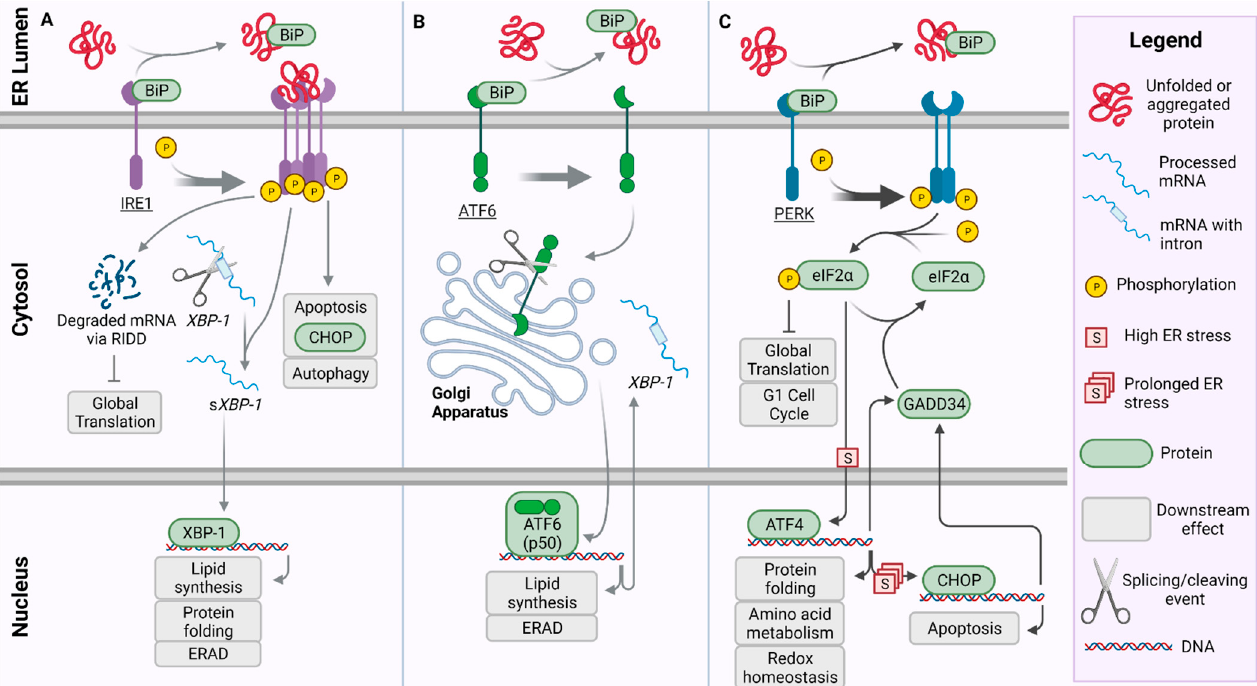
Figure 1. Pathways of the Unfolded Protein Response (UPR): In the presence of unfolded or aggregated protein, BiP dissociates from the three ER stress sensors: activating inositol requiring enzyme 1 (IRE1) ( A ), transcription factor 6 (ATF6) ( B ), and protein kinase RNA (PKR) like ER kinase (PERK) ( C ). The legend defines graphics for conserved structures between pathways of the UPR. ( A ) IRE1 forms a phosphorylated tetramer activating a cascade which promotes apoptosis via C/EBP homologous protein (CHOP) and autophagy. Simultaneously, IRE1 promotes the degradation of mRNA to reduce global translation via regulated IRE1-dependent decay (RIDD). The X-box-binding protein 1 ( XBP-1) mRNA is additionally spliced, allowing XBP-1 protein to translocate to the nucleus and promote the transcription of UPR target genes for protein folding, lipid synthesis, and endoplasmic-reticulum-associated protein degradation (ERAD). ( B ) Following release of BiP and activation, ATF6 translocates to the Golgi apparatus where it is cleaved into p50-ATF6. p50-ATF6 serves as a transcription factor for target genes, including those involved in ERAD, lipid synthesis, and XBP-1 which is translocated back to the cytosol. ( C ) PERK dimerizes and auto-phosphorylates, phosphorylating and inactivating eukaryotic initiation factor 2 alpha subunit (eIF2 α ). This reduces global translation and causes arrest of the G1 cell cycle via the adaptive UPR. Under high ER-stress conditions, activating transcription factor 4 (ATF4) is upregulated by phospho-eIF2 α , then promoting transcription of target genes involved in protein folding, amino acid metabolism, and redox homeostasis. Over prolonged ER-stress, pro-apoptotic CHOP is activated. Accordingly, CHOP up-regulates GADD34, which in turn dephosphorylates eIF2 α